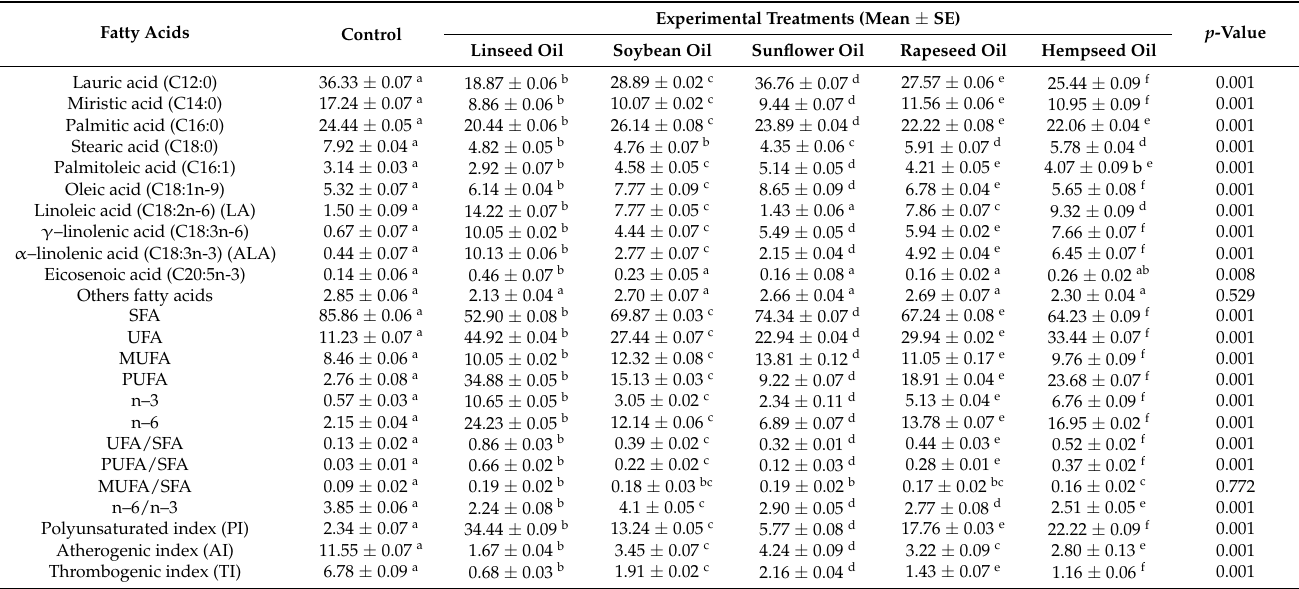
Table 5. The influence of vegetable oil inclusion in the diets of 20-day-old larvae on the fatty acid profile of fats (% of